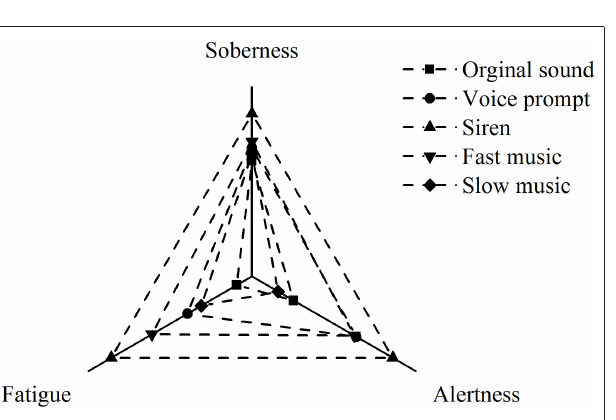
FIGURE 5 | Effect of different sound scenarios on drivers’ physiological state considering electroencephalogram (EEG)